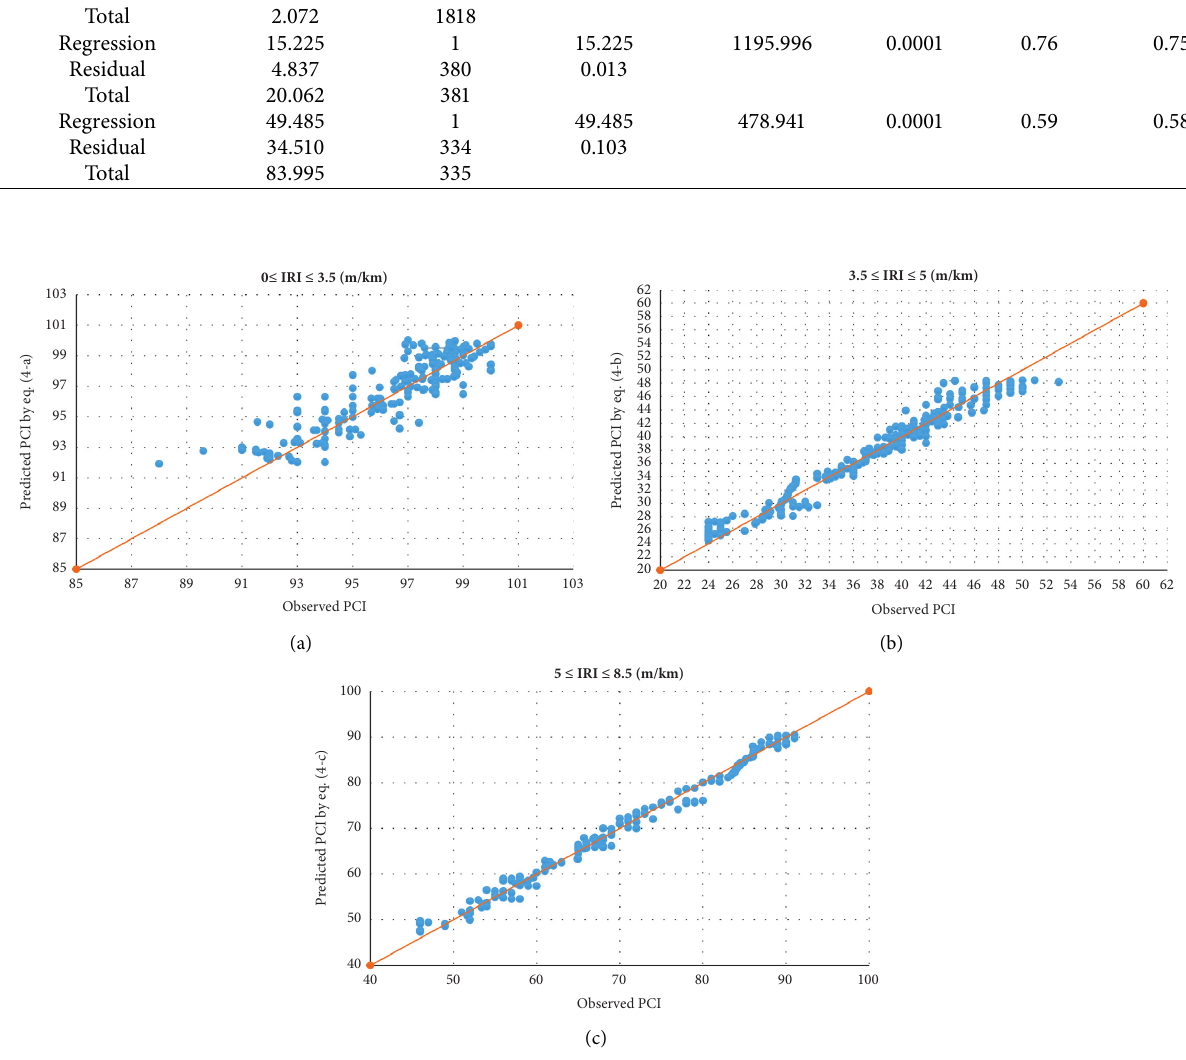
Figure 5: (a) Plot between predicted and measured PCI due to IRI, equation (4a). (b) Plot between predicted and measured PCI due to IRI, equation (4b). (c) Plot between predicted and measured PCI due to IRI, equation (4c).